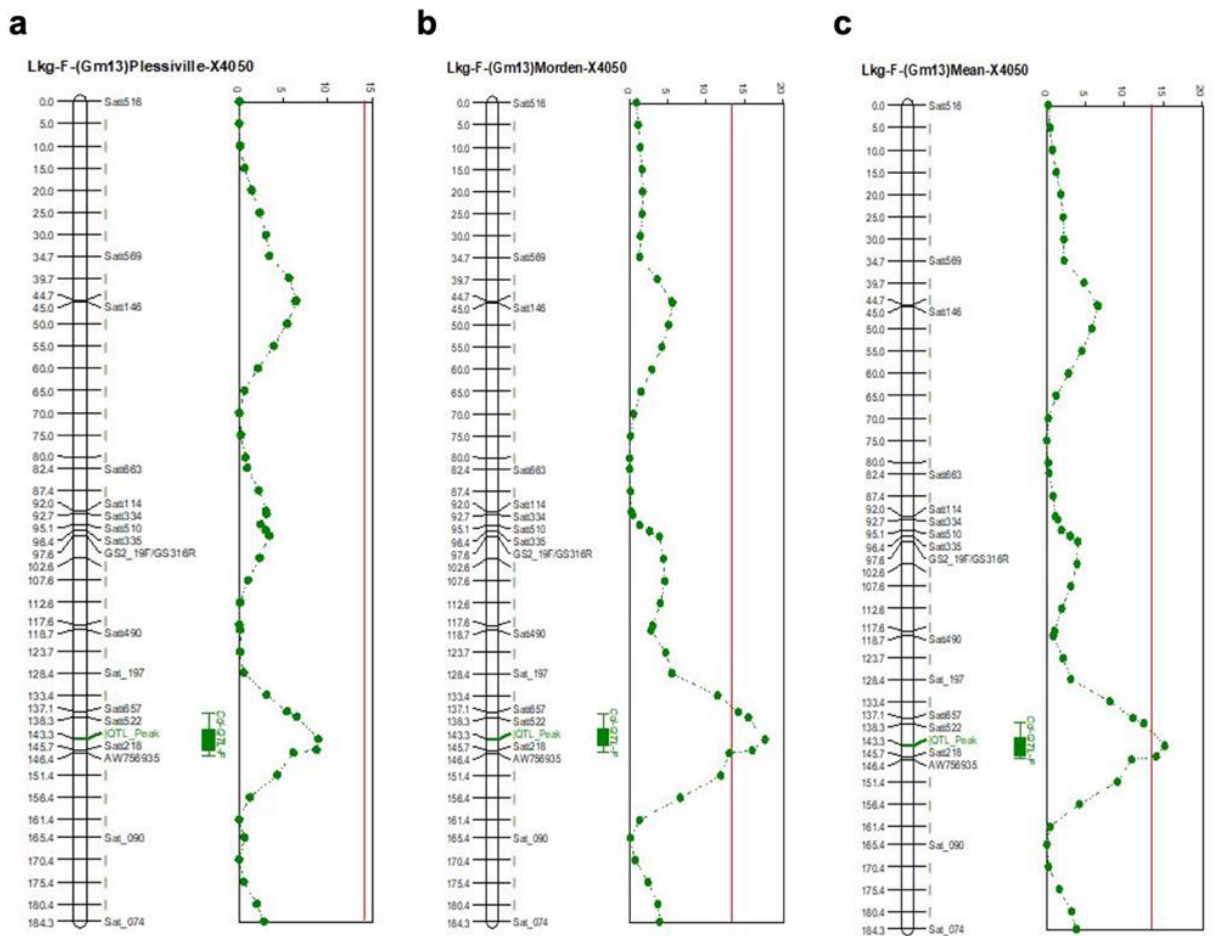
Figure 4 . Cd QTL for population X4050 Lkg-F with a threshold of 14.1 for Morden and 13.5 for